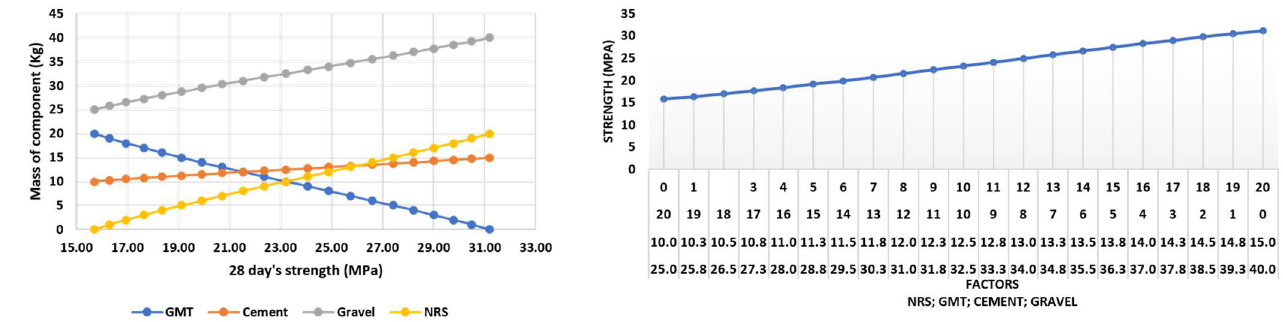
Figure 6. Compressive strength of concrete according to the variation of quantity of each compo- nent.